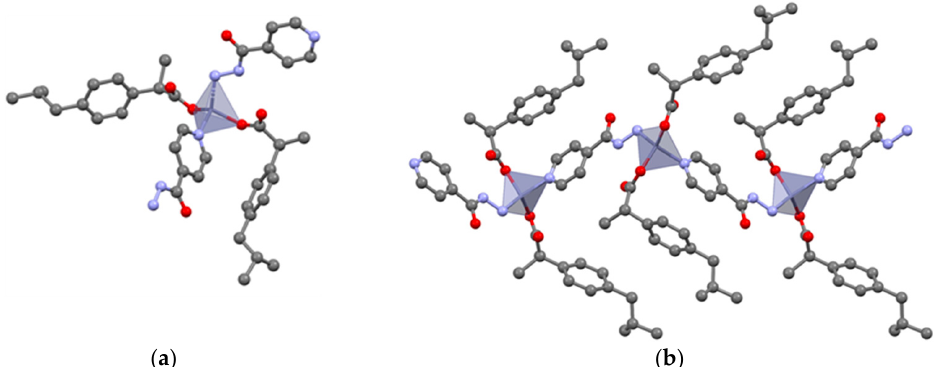
Figure 5. Zn(IBU) 2 (INZ): Tetra-coordinated zinc cation ( a ); one-dimensional chain ( b ). Hydrogen atoms omitted for clarity.